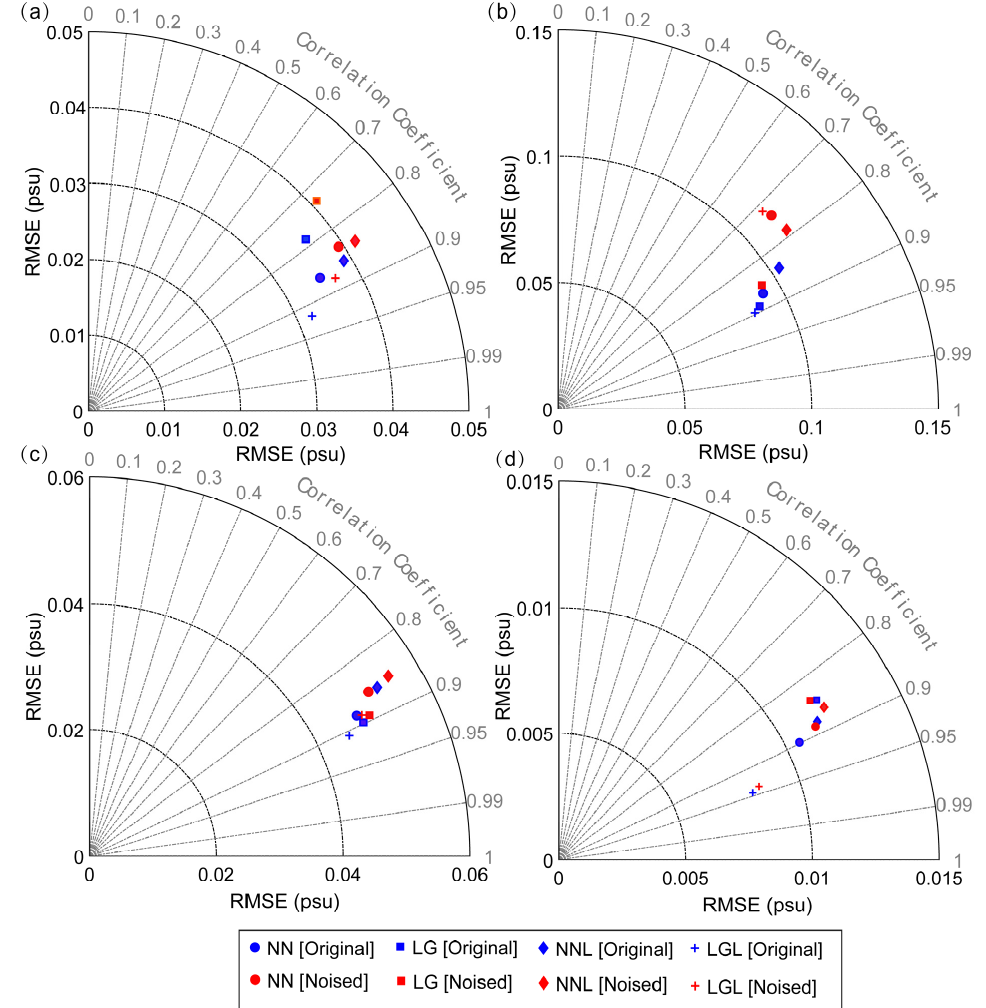
Figure 11. Average RMSEs and CCs in the 1–2000 m depth range and the RMSEs and CCs at three typical layers of the four experiments: ( a ) averaged over 1–2000 m; and in the depth of ( b ) 10 m; ( c ) 100 m; ( d ) 800 m. The scatter points in the diagrams represent different schemes, the radiation lines represent CCs, and the horizontal and vertical axes represent RMSEs .